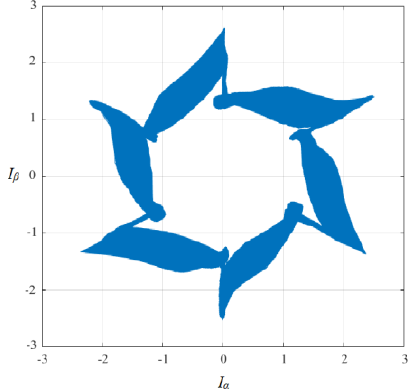
Figure 4. The equivalent current vector hodograph of the PMSM